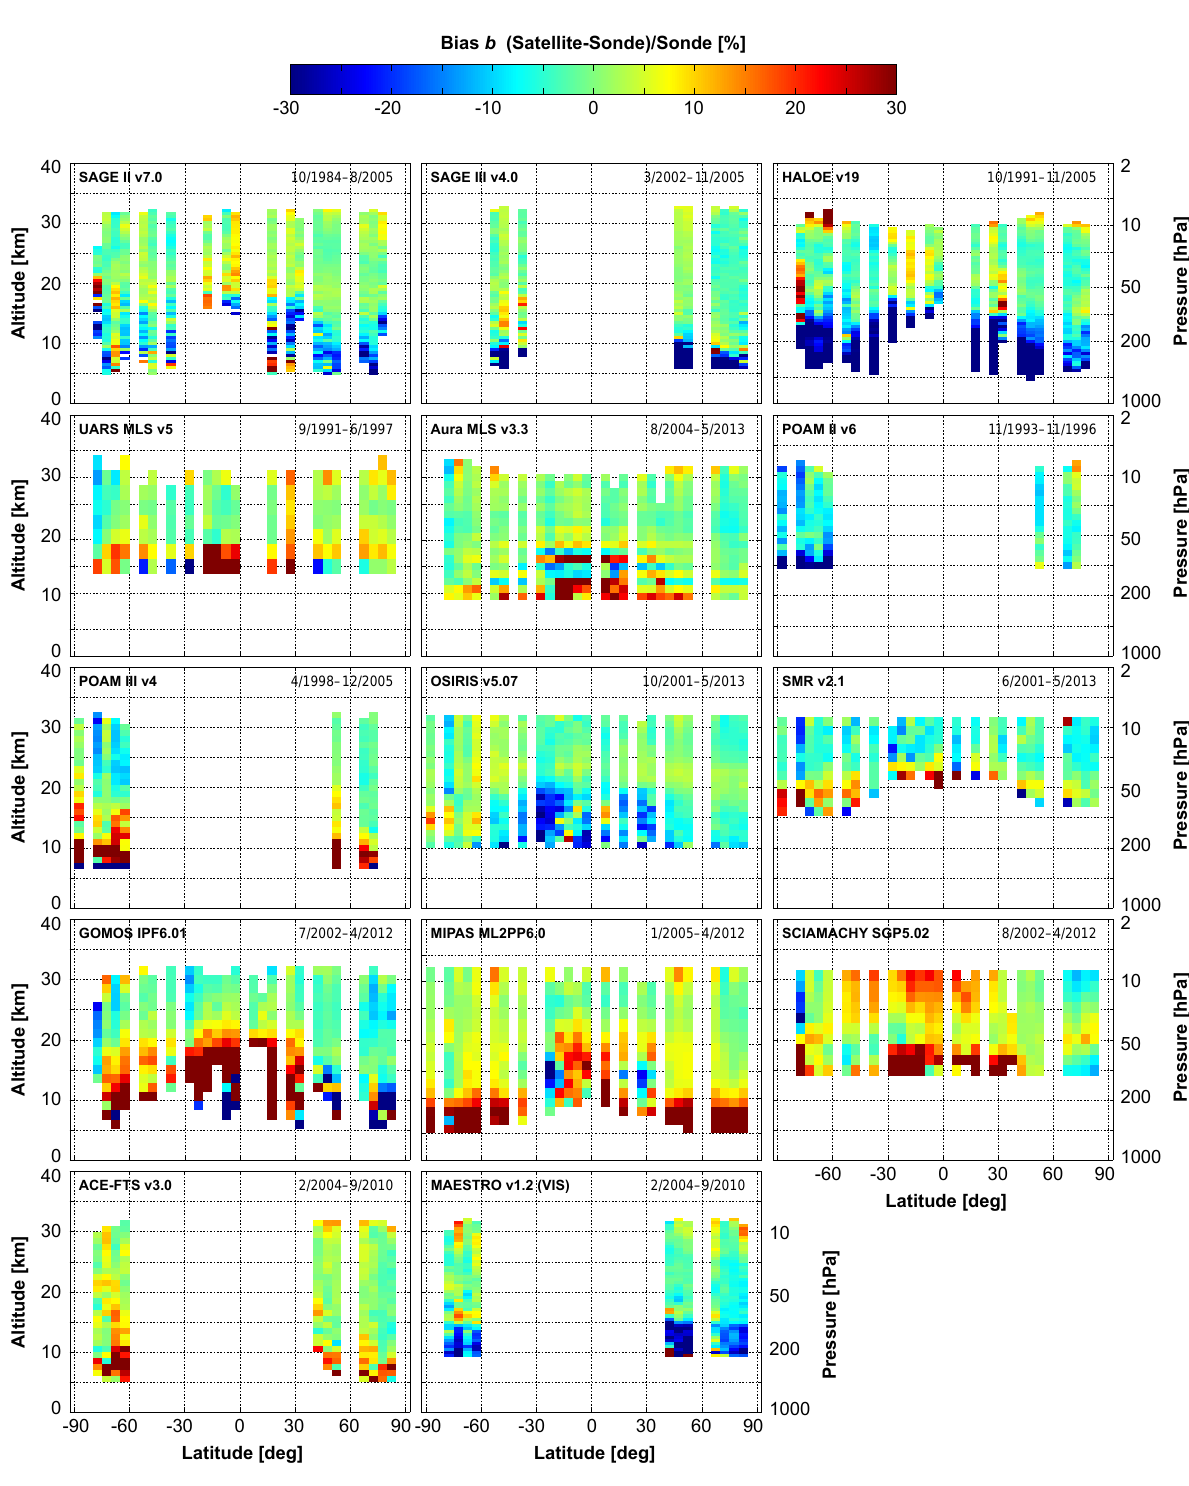
Figure 6. Meridional structure of the bias b relative to the ozonesonde network for all 14 satellite ozone profile records. The analysis is performed in the native profile representation of each satellite record. Only bins with more than five comparison pairs are